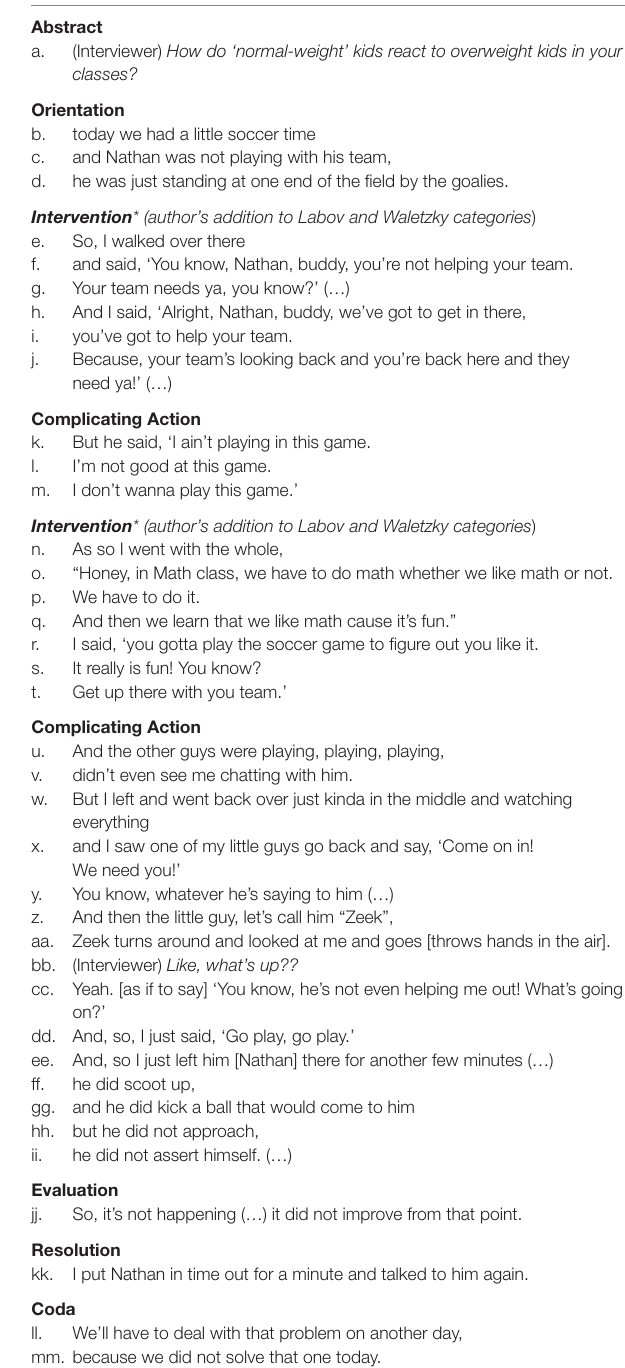
TaBle 1 | Structural analysis of narrative about